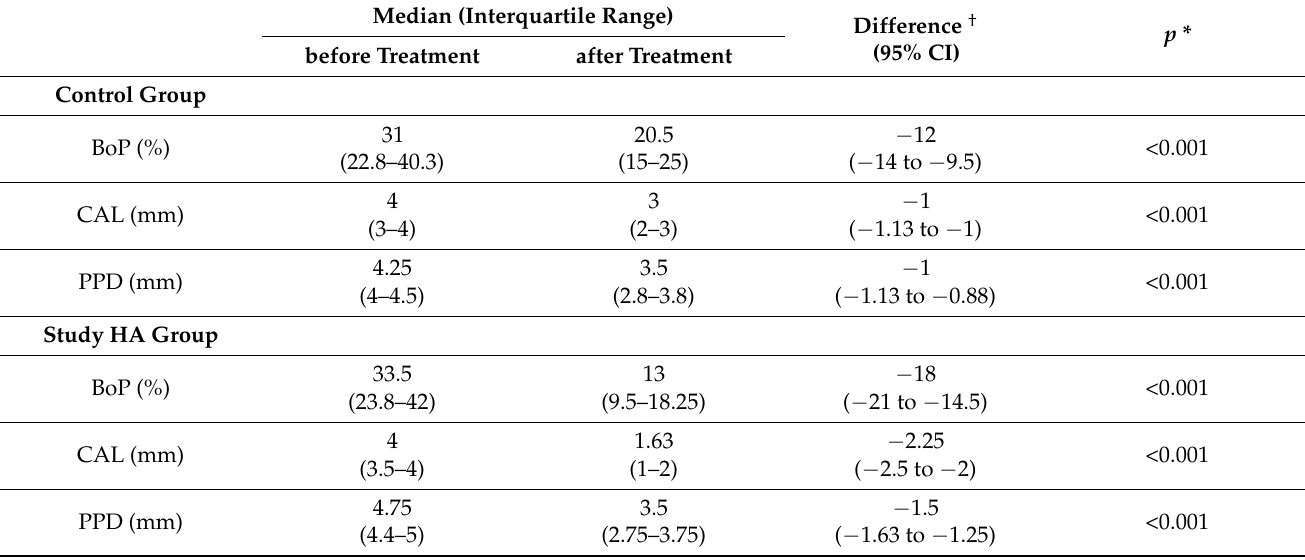
Table 2. Clinical parameters before and after treatment, within each treatment group.